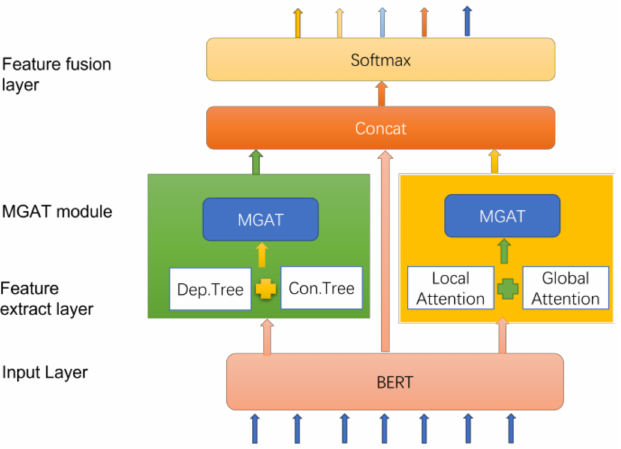
Figure 1. The framework of the proposed SSEMGAT